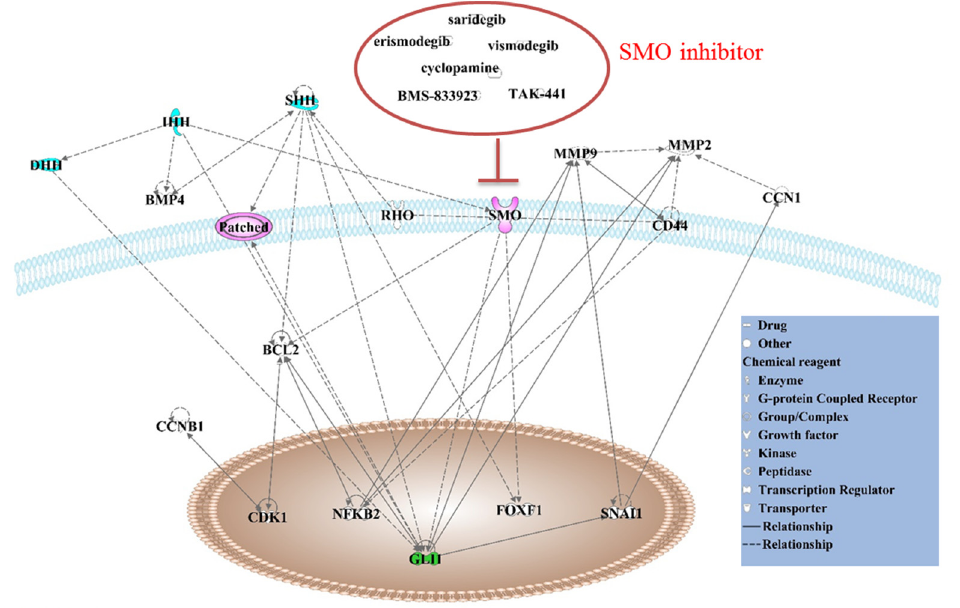
Figure 3. SMO in cancer. Major Hedgehog signaling pathway molecules, HH ligands, Patched, SMO and GLI, are labeled in color. SMO inhibitors include vismodegib (GDC-0449), cyclopamine, TAK-441, etc. Molecules (MMP2, Rho, FoxF1, Bcl2, NFKB, etc.) interact with Hedgehog molecules; the direct interactions between molecules are shown with solid lines and the indirect relationships between molecules are shown with dotted lines. The figure was plotted using Ingenuity Pathway Analysis software.